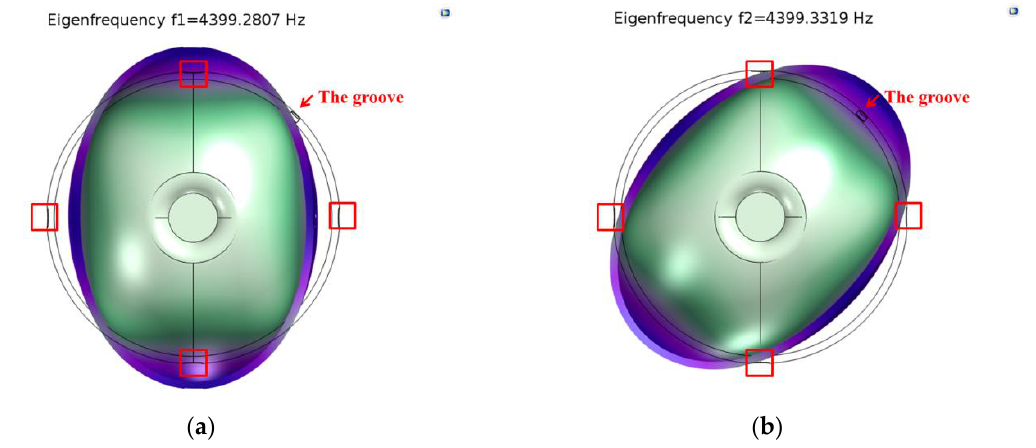
Figure 5. Eigen frequencies of the n = 2 mode after etching. ( a ) f 1 = 4399.2807 Hz; ( b ) f 2 = 4399.3319 Hz.